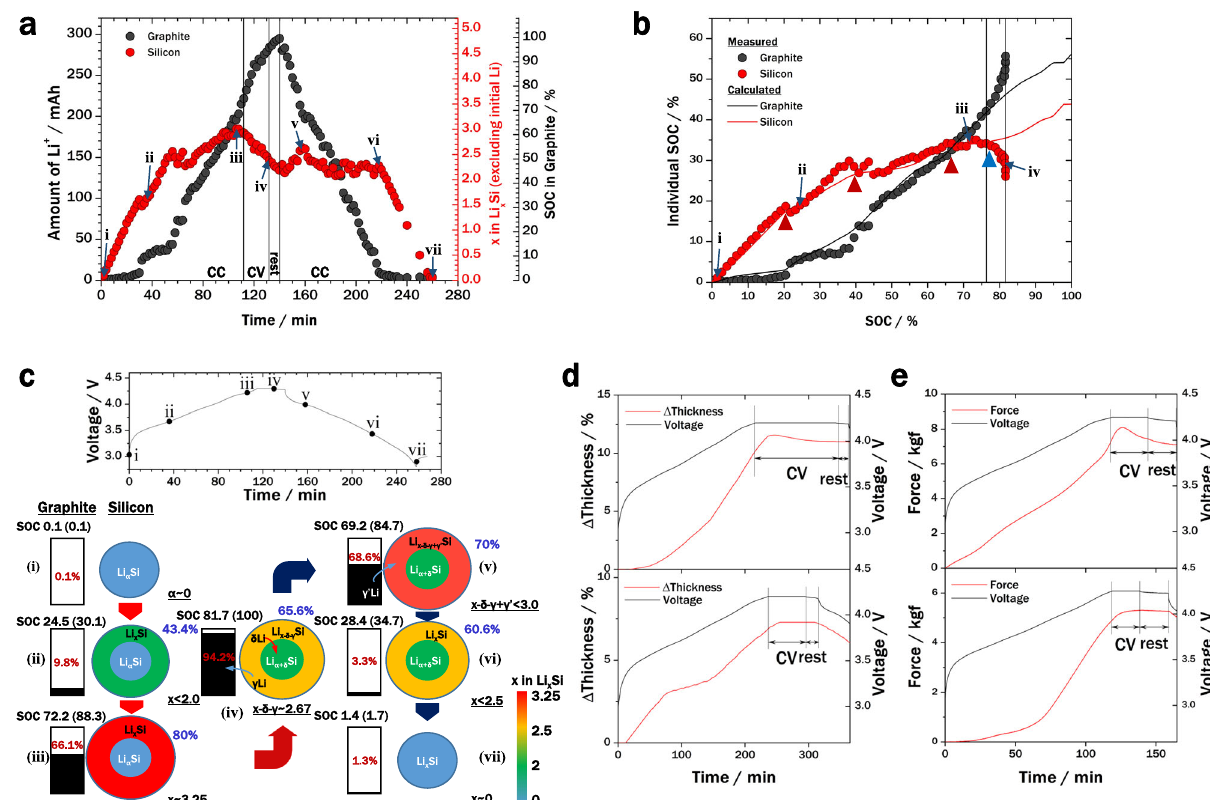
Fig. 1 Deconvolution of the mixed state of Cell B at 0.5C. a Deconvolution of the mixed state of the anode of Cell B into individual silicon and graphite states. b Amount of Li + in the calculated and experimental (lines and circles, respectively) states-of-charge (SOCs) for individual components. The discrepancies at high SOCs originate from the utilisation of the active materials and the negative to positive ( n / p ) ratio. c Voltage pro fi le (upper panel) and schematics of active materials at various anode SOCs (lower panel). The letters i – vii correspond to the points in ( a ) and ( c ) (upper panel). The numbers in parentheses represent the full-cell SOCs, and the corresponding graphite and silicon SOCs are indicated in red and blue, respectively. d Thickness variations ( Δ thickness; red line) and voltage pro fi les (black line) of the cells using silicon – graphite (upper panel) and graphite (lower panel) during constant current (CC) – constant voltage (CV) charging and rest mode at a C-rate of 0.25 C. The charging start time is set to 0 min. e Evolution of forces on the pouch cells (red line) and corresponding voltage pro fi les (black line) of cells using silicon – graphite (upper panel) and graphite-only (lower panel) anodes during CC – CV charging and rest mode at 0.5